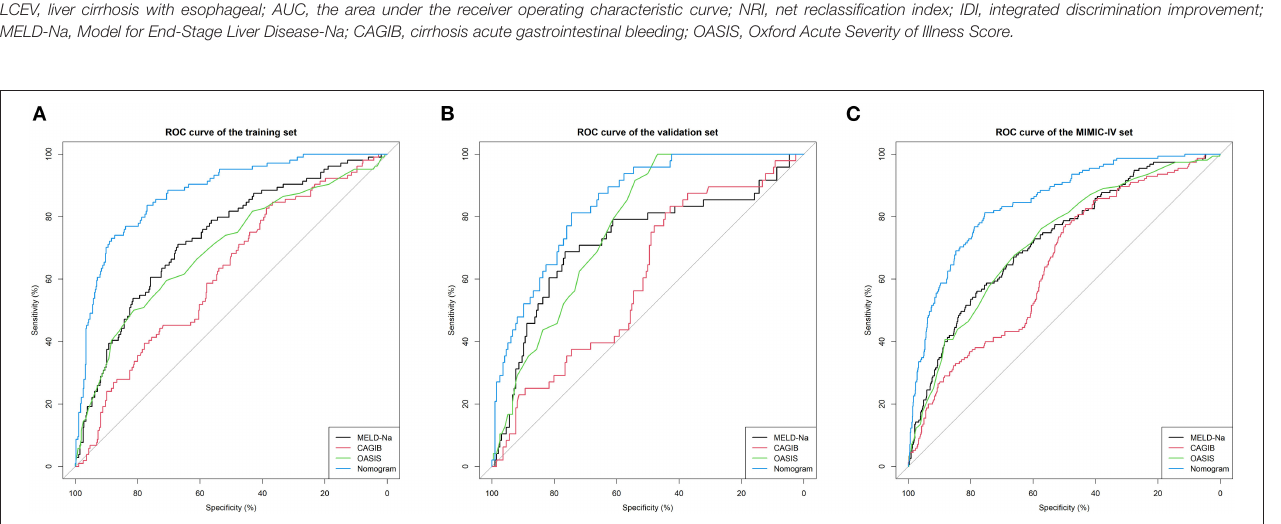
FIGURE 3 | ROC curves. ROC curves were generated to validate the discrimination of the models, by the areas under the ROC curves. (A–C) came from the training, validation, and MIMIC-IV cohorts, respectively. LCEV, liver cirrhosis with esophageal; MELD-Na, Model for End-Stage Liver Disease-Na; CAGIB, cirrhosis acute gastrointestinal bleeding; OASIS, Oxford Acute Severity of Illness Score.